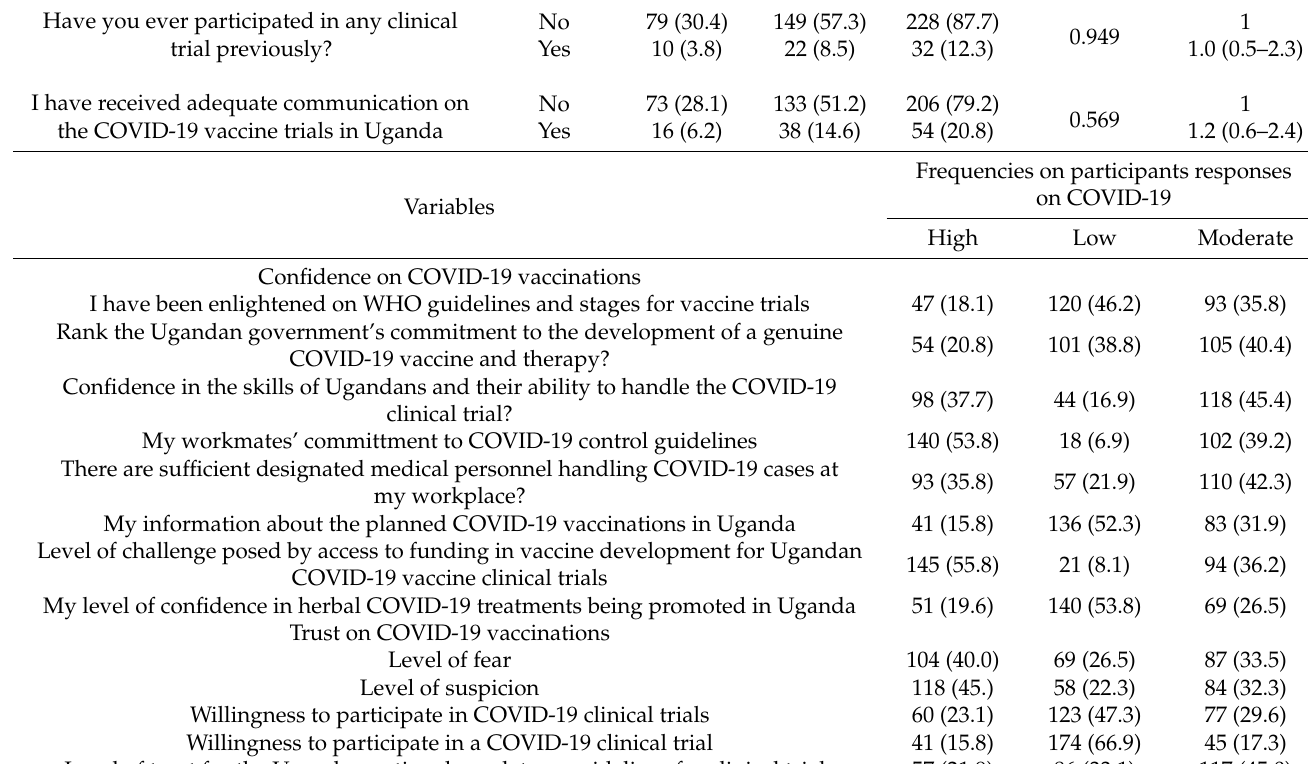
KEY: OR = Odds ratios, 95% CI = confidence